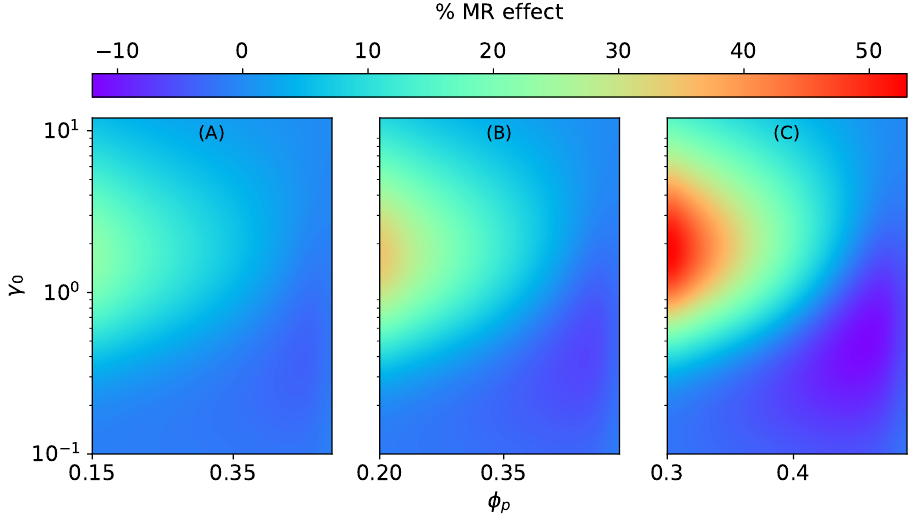
(cid:16) (cid:17) K (cid:107) of an ellipsoidal MAE with SD microstructure SD